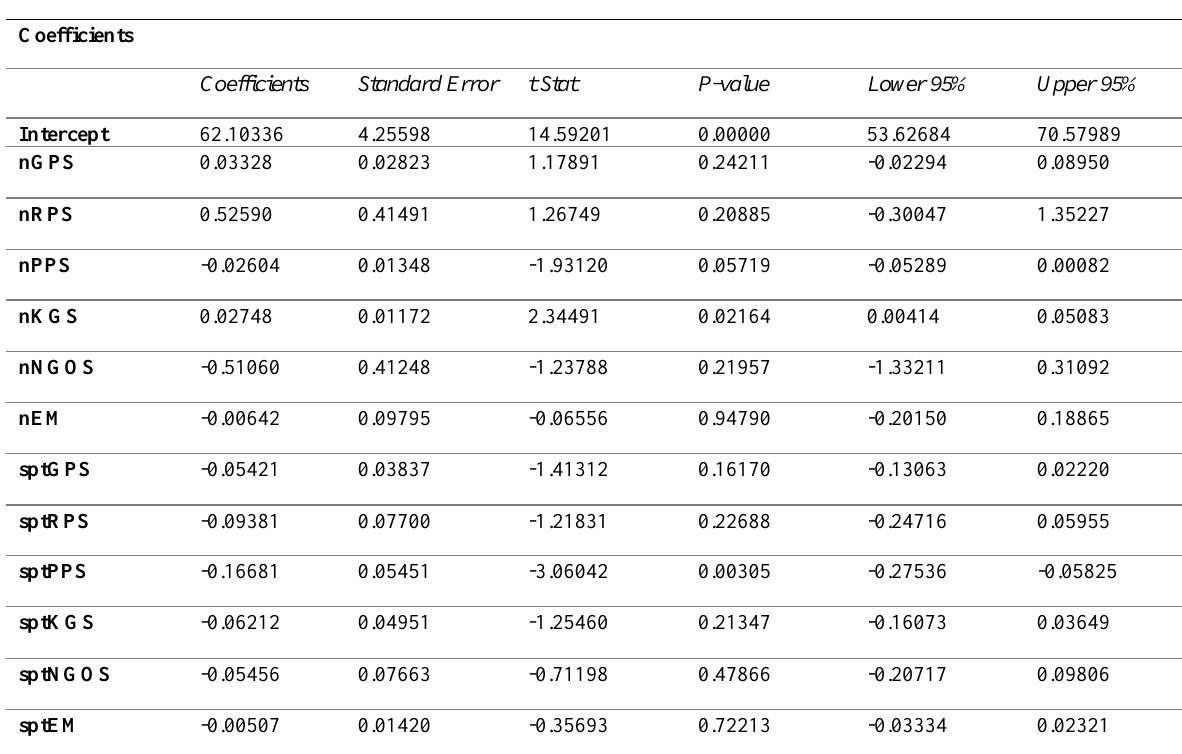
Table 12: Coefficients (Dhaka